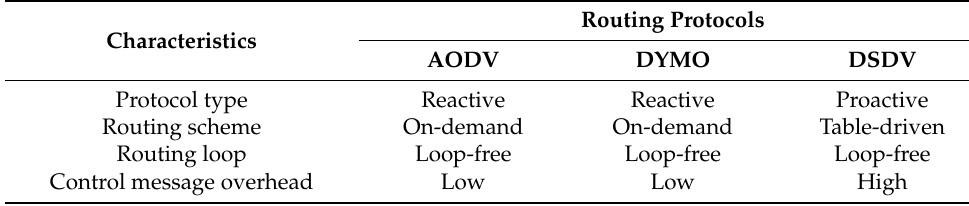
Table 1. Comparison of Ad-hoc routing